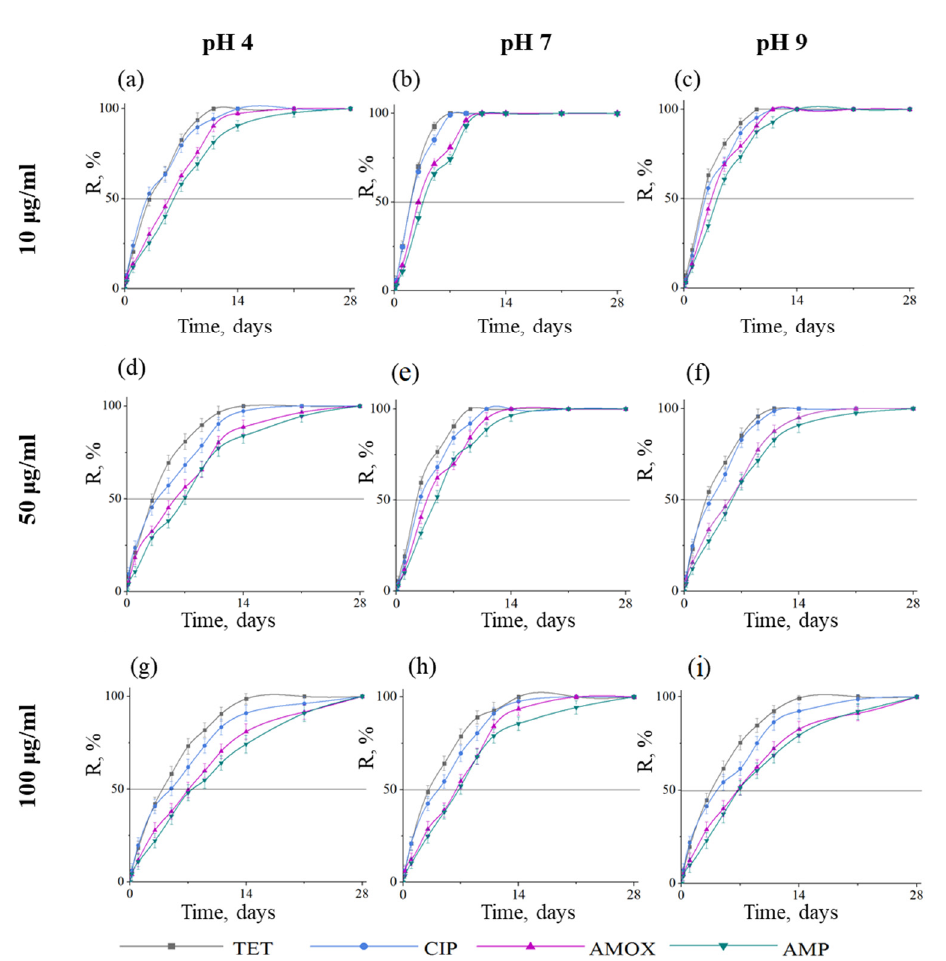
Figure 4. Kinetic curves showing the removal efficiency of four types of antibiotics during the second cycle (after cleaning of BN coated samples) at pH 4 ( a , d , g ), pH 7 ( b , e , h ), and pH 9 ( c , f , i ) and initial antibiotic concentrations of 10 ( a – c ), 50 ( d – f ) and 100 µg/mL ( g – i ). T = 25 °C. TET and CIP adsorb on the surface of BN best of all and approximately equally.